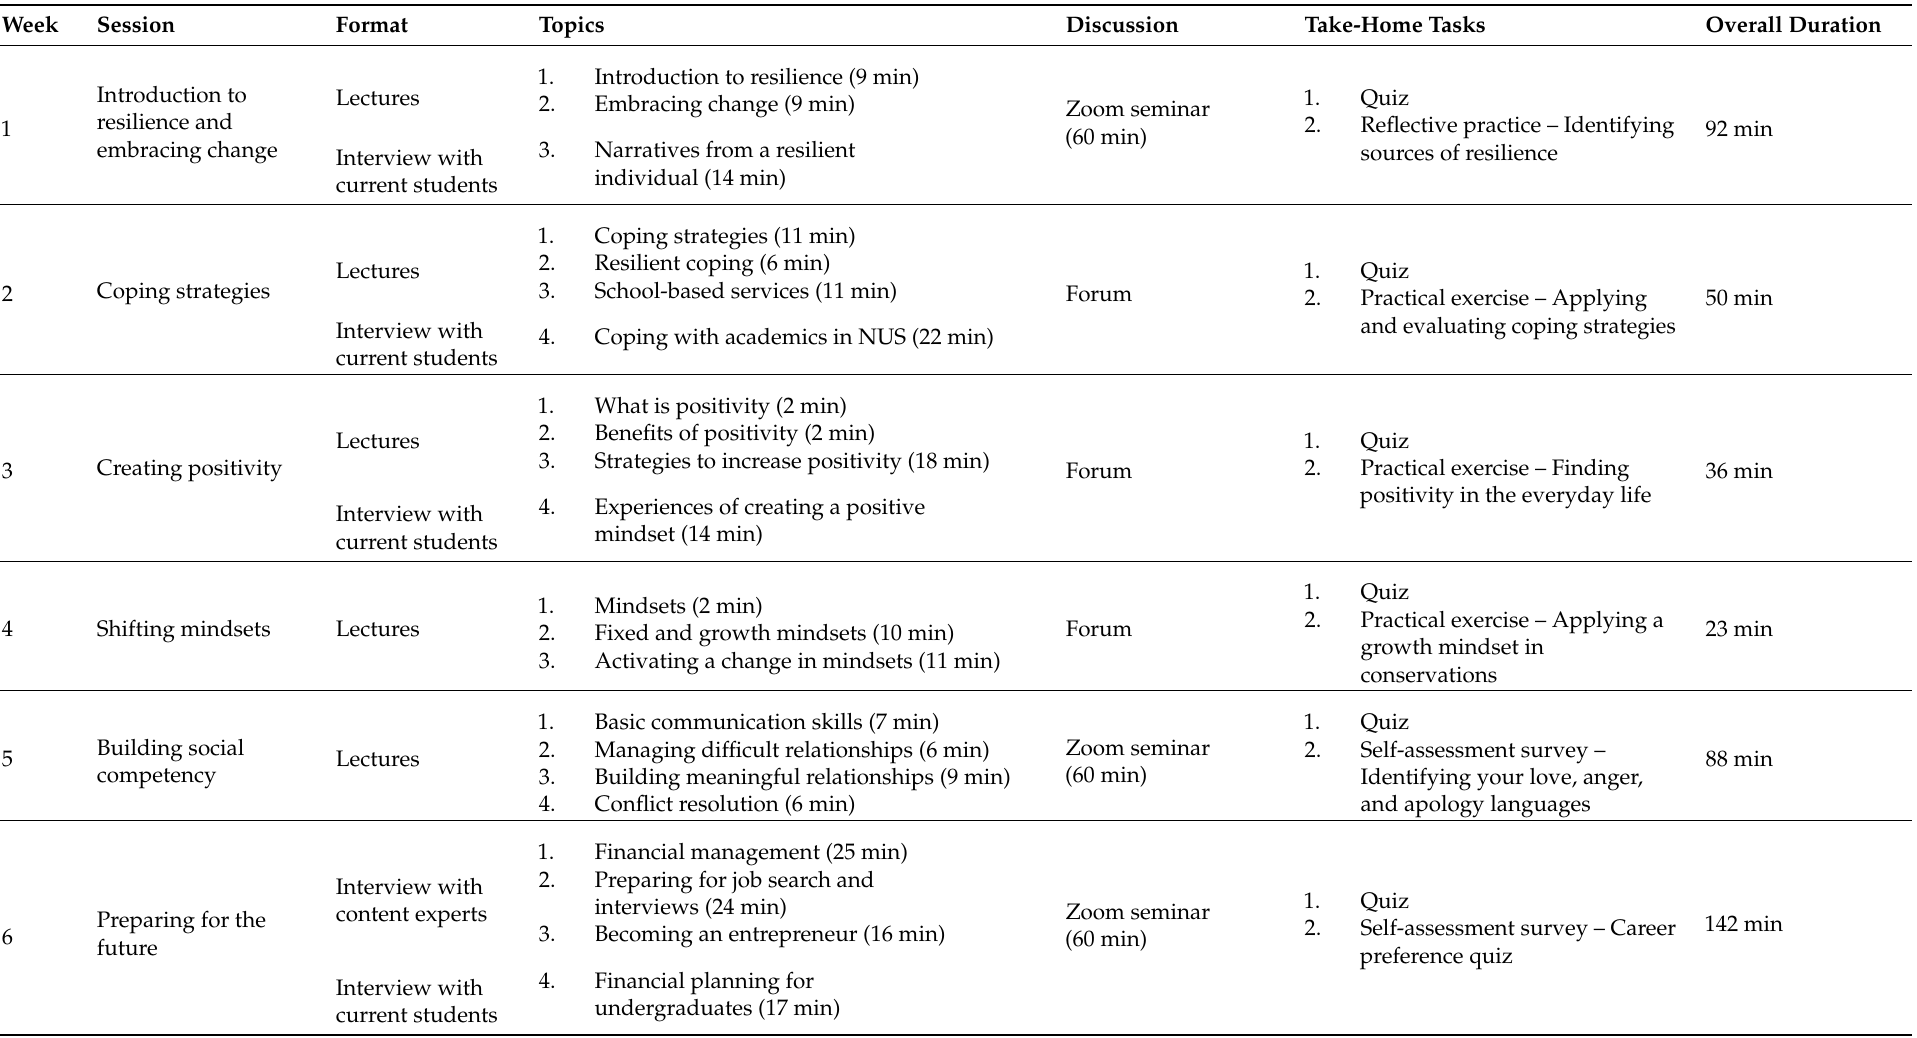
Table 1. Resilience Skill Enhancement (RISE)